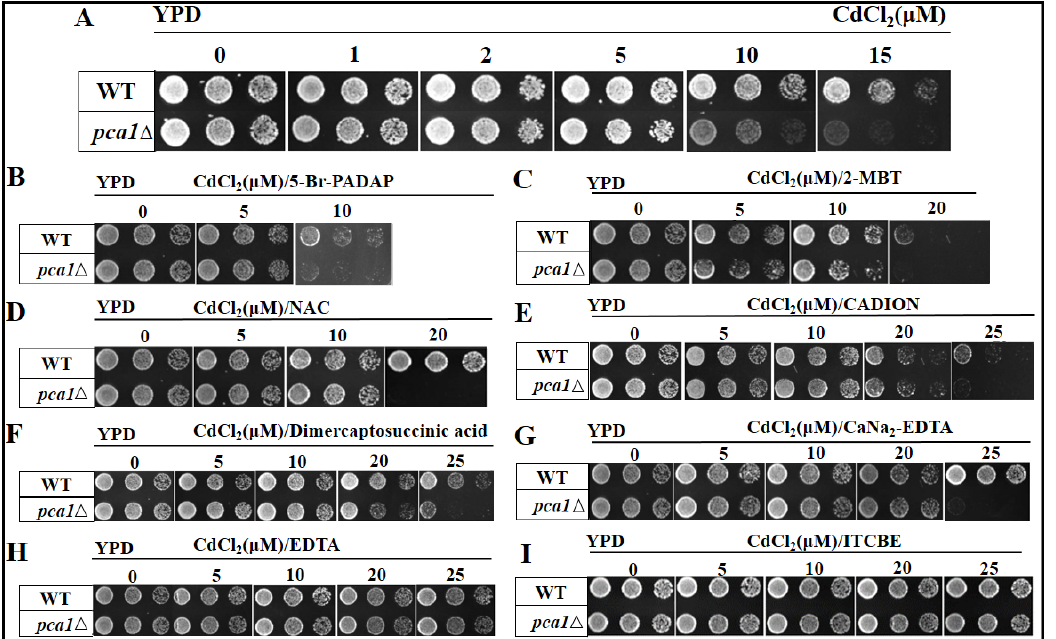
Figure 1. The growth of WT and pca1 Δ yeast strains incubated with various chelators plus distinct concentrations of Cd 2+ . ( A ) Different concentrations of Cd 2+ (0, 1, 2, 5, 10, and 15 μM); ( B ) Different concentrations of Cd 2+ (0, 5, and 10 μM) plus 5-Br-PADAP (0, 10, and 20 μM); ( C ) Different concen- trations of Cd 2+ (0, 5, 10, and 20 μM) plus 2-MBT (0, 10, 20, and 40 μM); ( D ) Different concentrations of Cd 2+ (0, 5, 10, and 20 μM) plus NAC (0, 10, 20, and 40 μM); ( E ) Different concentrations of Cd 2+ (0, 5, 10, 20, and 25 μM) plus CADION (0, 10, 20, 40, and 50 μM); ( F ) Different concentrations of Cd 2+ (0, 5, 10, 20, and 25 μM) plus dimercaptosuccinic acid (0, 10, 20, 40, and 50 μM); ( G ) Different con- centrations of Cd 2+ (0, 5, 10, 20, and 25 μM) plus CaNa 2 -EDTA (0, 10, 20, 40, and 50 μM); ( H ) Different concentrations of Cd 2+ plus EDTA (0, 10, 20, 40, and 50 μM); (I) Different concentrations of Cd 2+ (0, 5, 10, 20, and 25 μM) plus ITCBE (0, 10, 20, 40, and 50 μM).